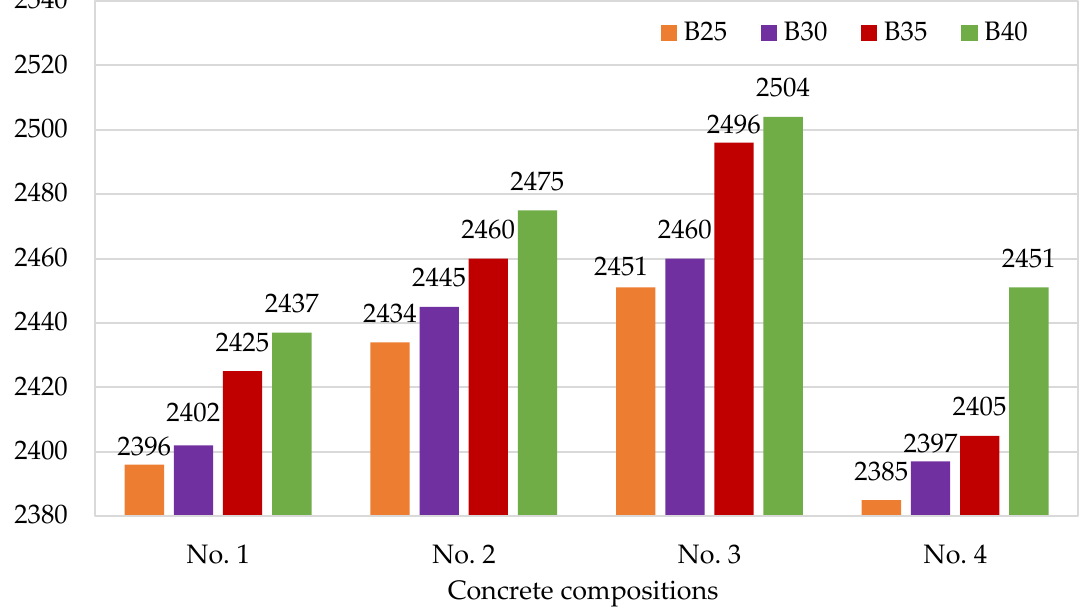
Figure 4. Dependence of flexural strength on the application of modifiers and volumetric fiber reinforcement: No. 1—no additives; No. 2—with CCM; No. 3—with CCM and HPC; No. 4—with CCM, HPC, and fiber.